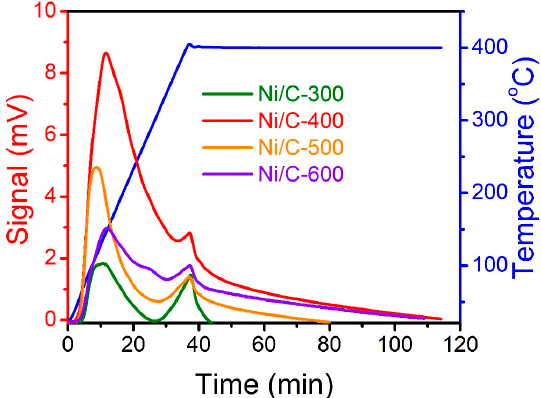
Figure 5. H 2 -TPD curves of the MOF-74-derived Ni/C catalysts at different temperatures. The metal surface area and particle dispersion of MOF-74-derived Ni/C catalysts are calculated by pulsed H 2 chemisorption, and the results are listed in Table S4. The results show that both the metal surface area and particle dispersion of Ni/C-400 are notably higher than others, which is an important factor resulting in high catalytic performance. The low metal surface area and particle dispersion of Ni/C-300 are mainly attributed to the lower reduction ratio in MOF-74, although the particle size of metallic Ni is similar to